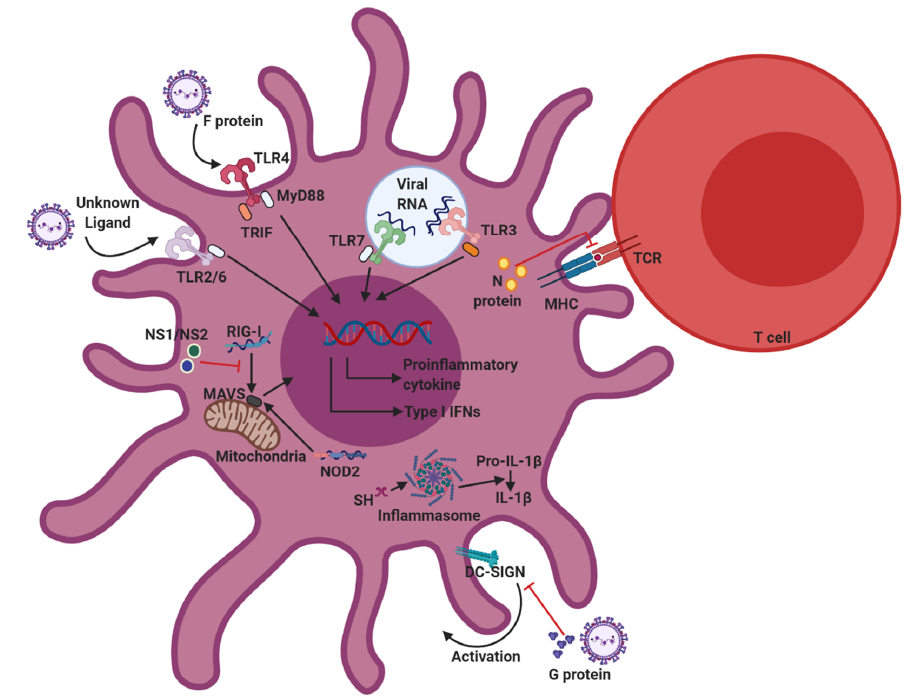
Figure 2. Innate sensors involved in RSV recognition, and immunomodulation strategies of RSV. Upon RSV infection, Toll-like receptors (TLR)2 / 6, TLR3, TLR4, TLR7, retinoic acid-inducible gene-I (RIG-I), and nucleotide-binding oligomerization domain (NOD2) are responsible for recognizing RSV pathogen-associated molecular patterns (PAMPs) in dendritic cells (DCs). The recognition of PAMPs by pattern recognition receptors (PRRs) activates downstream signaling pathways, which trigger DC activation and cytokine production. To avoid host immune responses, RSV has evolved various immunomodulatory strategies that inhibit DC functions. RSV proteins, specifically proteins G, NS1 / NS2, and N, contribute to immunomodulation of